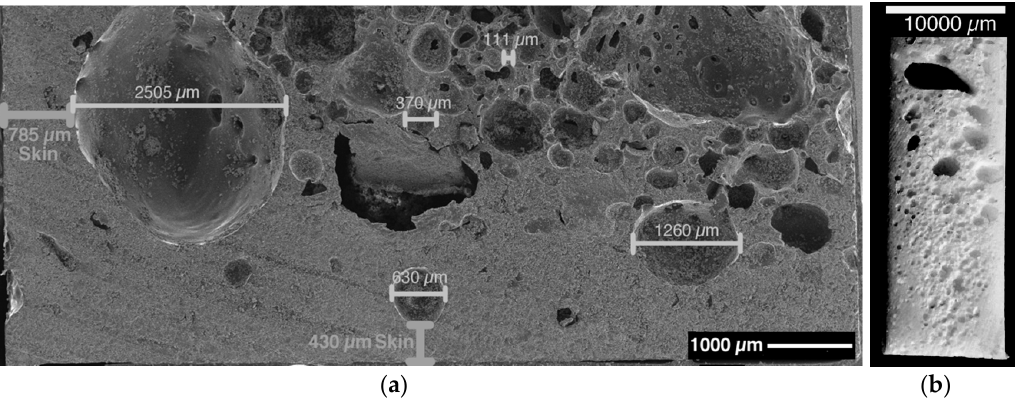
Figure 8. Integral foam structure of m2-DGEBA (50:50 stoichiometric AEP and B-AEP). ( a ) SEM image of top left edge region with some indicated values of skin thickness and cell diameter; ( b ) Photo of sample center region at sample cured vertically for better illustration of cell size distribution; bottom small sized, upwards increasing.